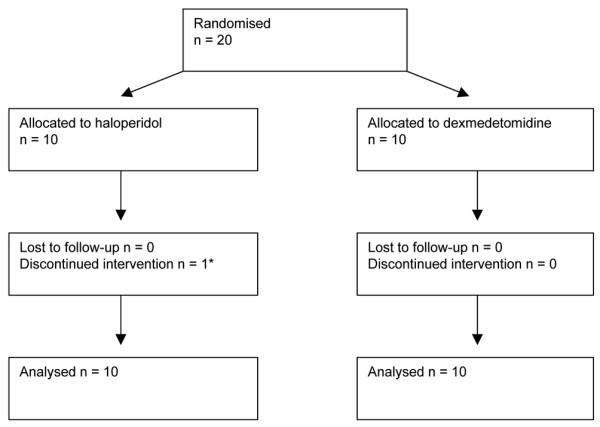
[CONSORT patient flow diagram 44]. * Intervention was discontinued because of consultant physician concern at the length of the QTc interval.